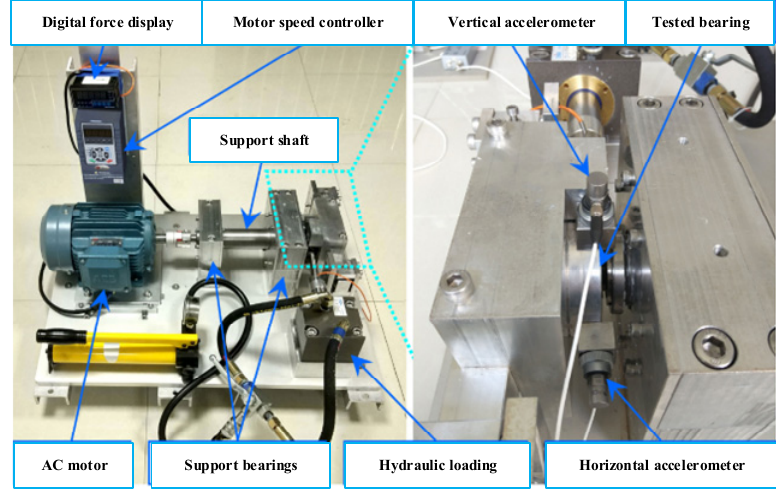
Figure 7. Rolling-bearing-life data-acquisition-experiment platform [22].